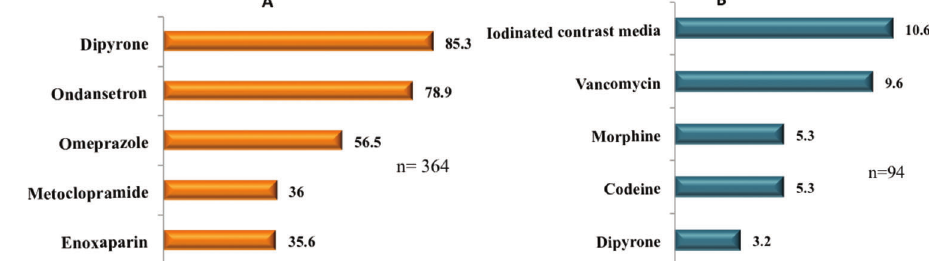
Figure 2 - Most frequently prescribed medications (A) and medications associated with ADRs (B). ADR: Adverse drug